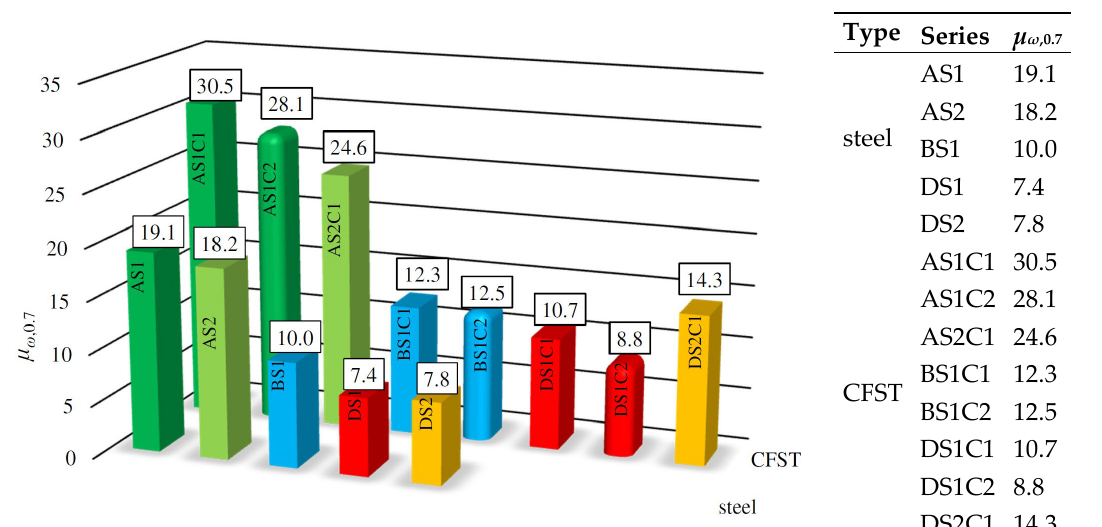
Figure 17. Ductility of steel and CFST columns calculated using proposed μ ω, 0.7 measure.